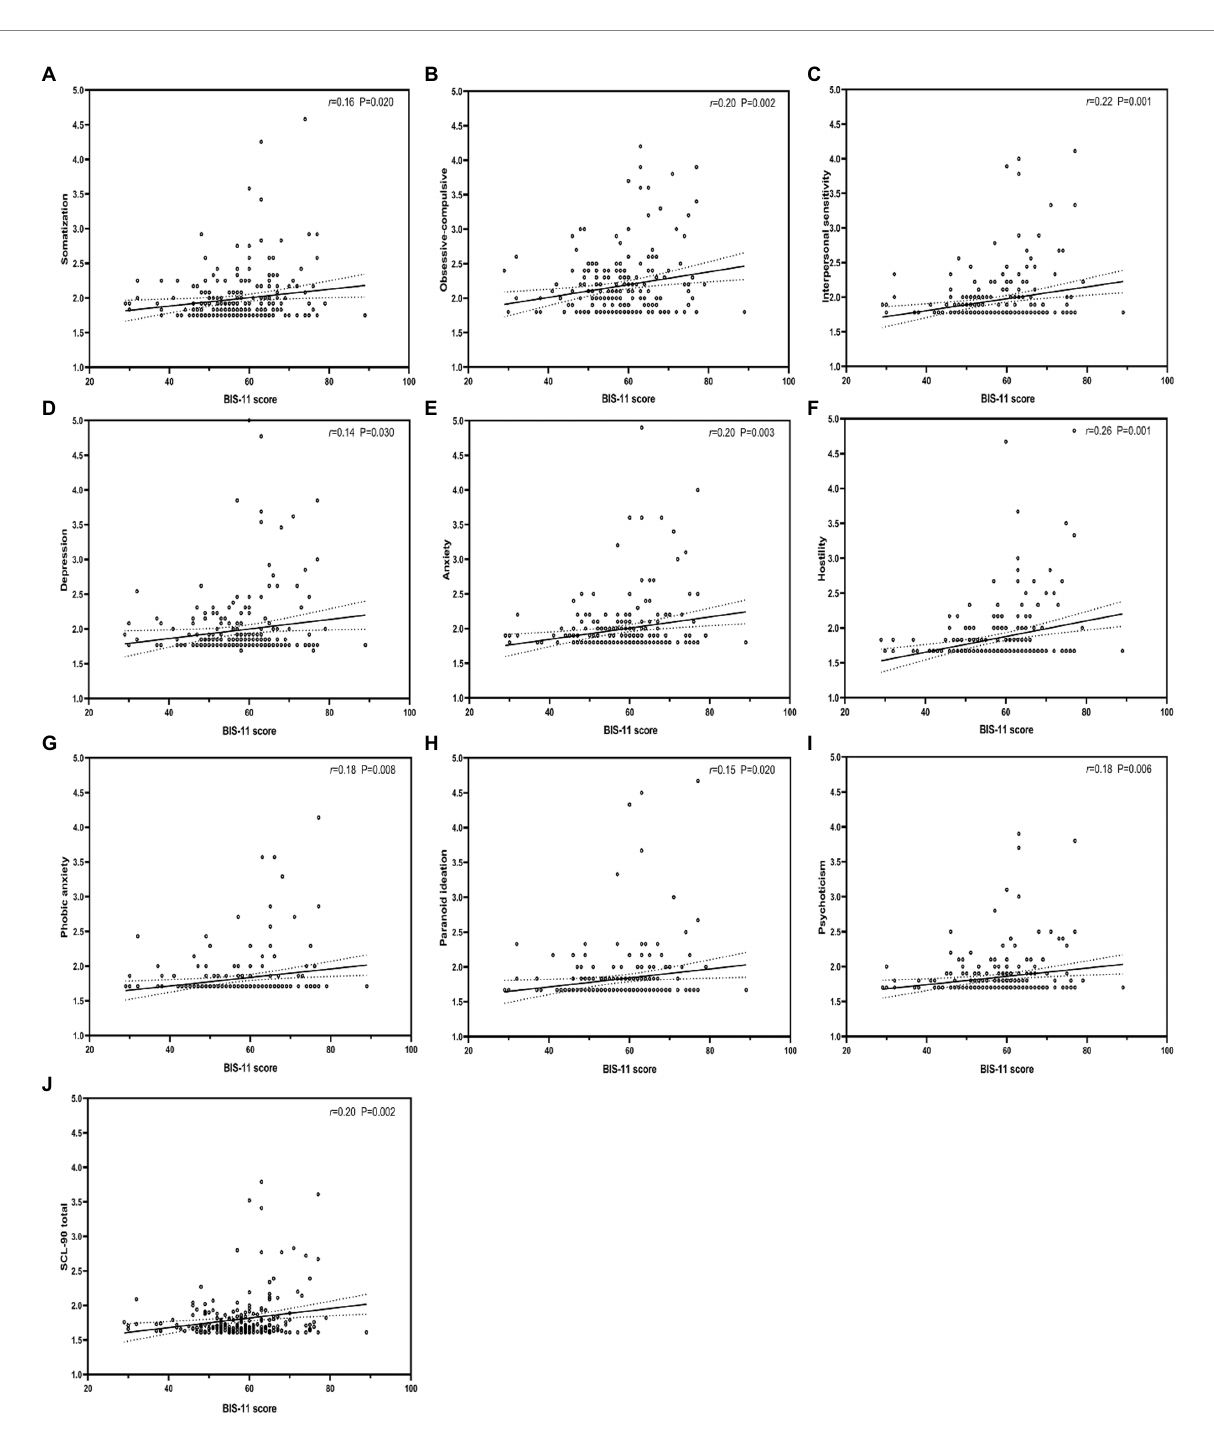
FIGURE 1 Correlation between impulsivity and each dimension of SCL-90. BIS-11, Barratt Impulsiveness Scale-11. r: Pearson correlation coefficient; p: p